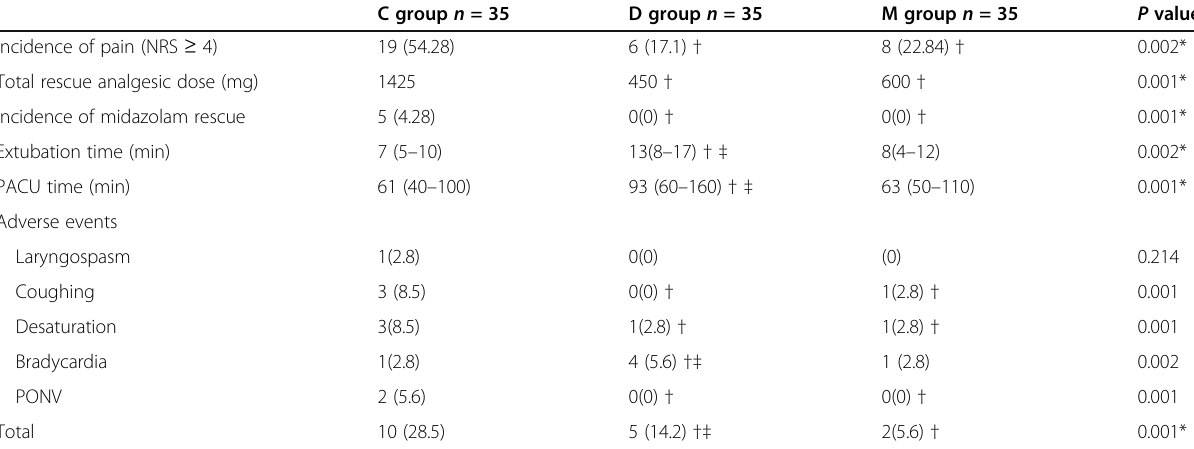
Table 3 Recovery